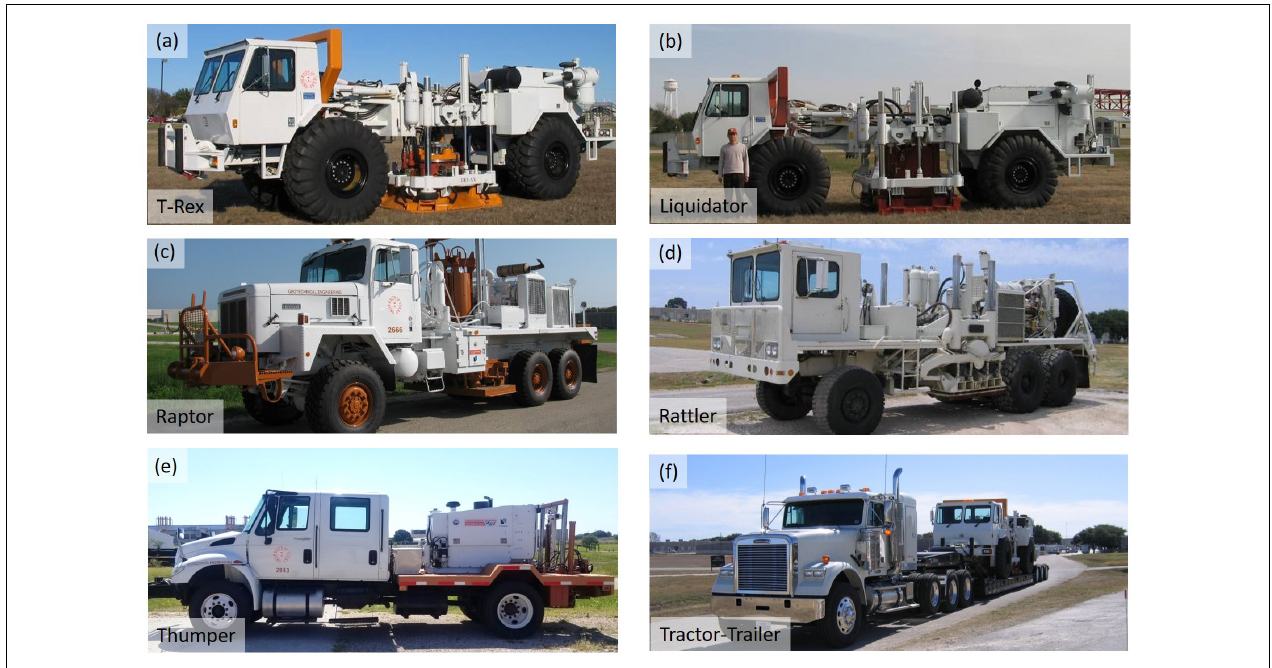
FIGURE 1 | Photographs of the five mobile shakers and tractor-trailer rig available at NHERI@UTexas: (a) High-force, three-axis shaker called T-Rex, (b) Low-frequency, two-axis shaker called Liquidator, (c) Single-axis, vertical shaker called Raptor, (d) Single-axis, horizontal shaker called Rattler, (e) Urban, three-axis shaker called Thumper, and (f) Tractor-trailer rig, called the Big Rig, with T-Rex (after Stokoe et al., 2017). TABLE 1 | Key features of these five shakers available at NHERI@UTexas.